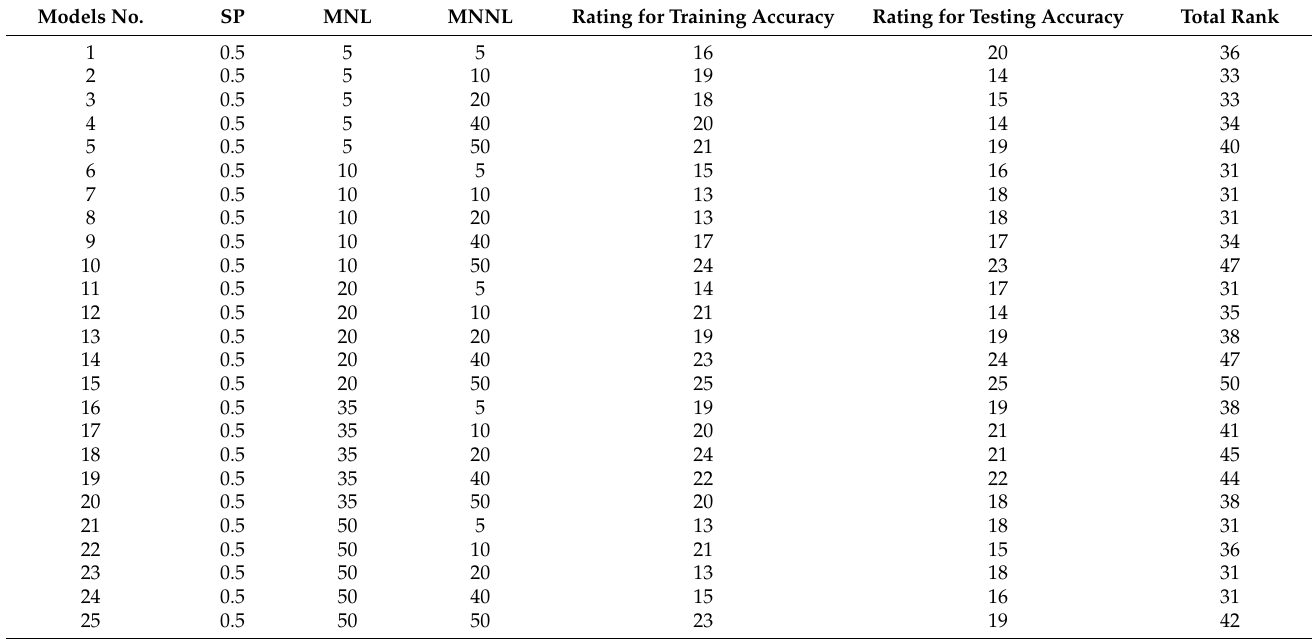
Table 5. Ranking of developed